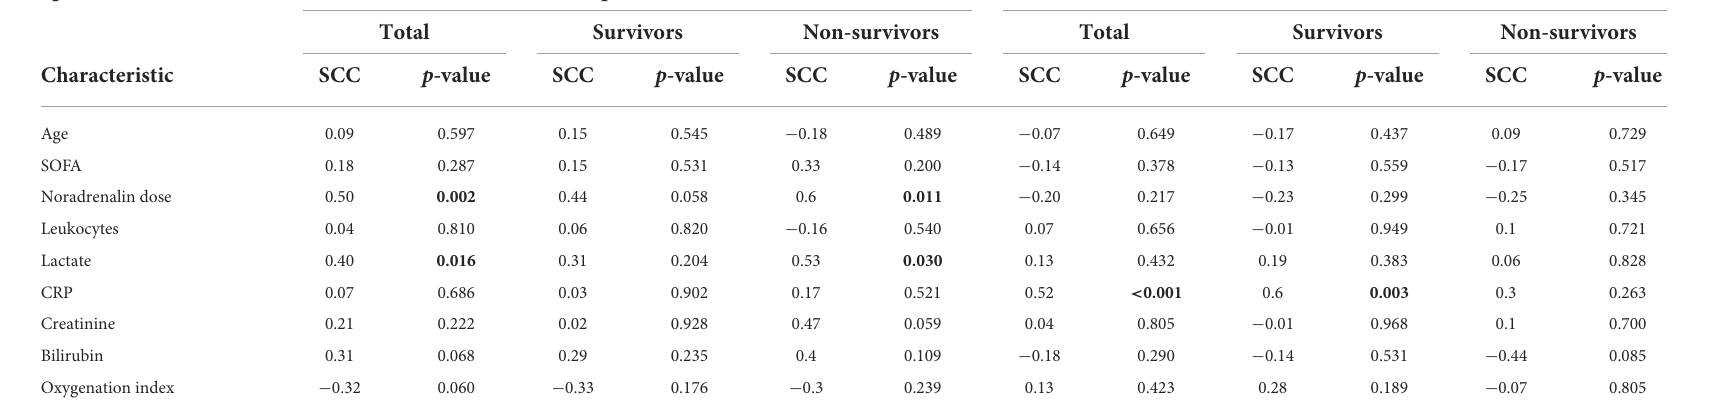
TABLE 4 Correlations and its significance of sEng to other characteristics. Spearman’s